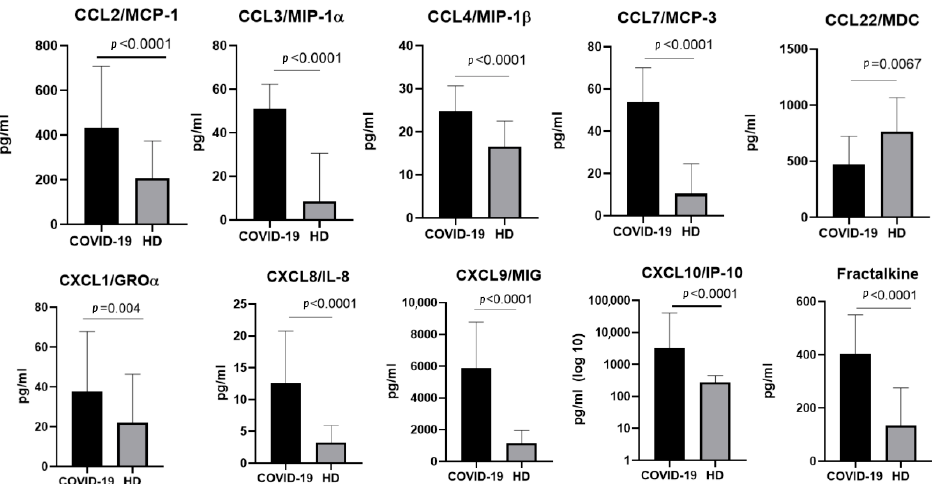
Figure 2. A comparison of the concentrations of the chemokines in the plasma of individuals infected with the Alpha variant of SARS-CoV-2 in the acute stage (COVID-19), n = 95, and in healthy donors (HD), n = 51. The concentrations are presented in pg/mL plots representing medians with interquartile ranges. Only chemokines with a statistically significant difference are presented.